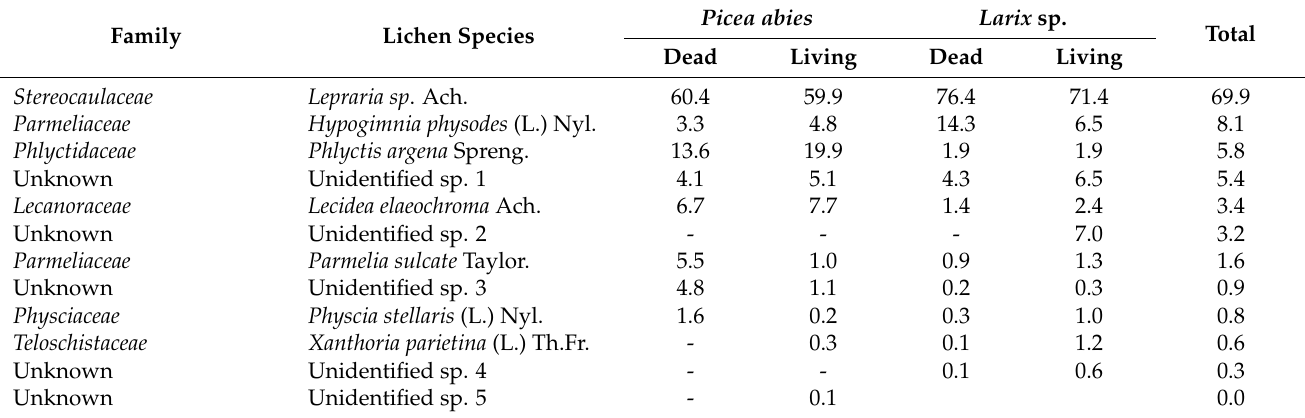
Table 7. Relative abundance (%) of epiphytic lichen species on colonized dead and living P. abies and Larix sp. trees. Different sampling sites are combined.